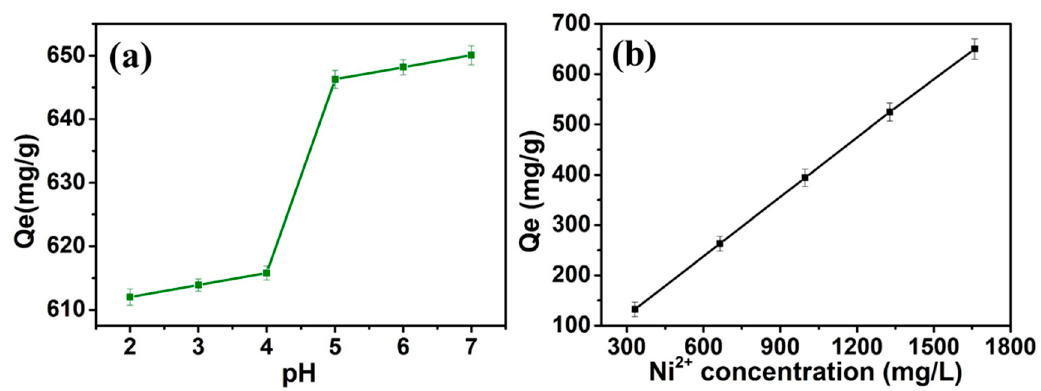
Figure 5. Effect of ( a ) pH ( b ) initial Ni 2+ concentration on the adsorption capacity of Figure 5. E ff ect of ( a ) pH ( b ) initial Ni 2 + concentration on the adsorption capacity of gauze@PEI 0.4 / gauze@PEI 0.4 /PEGDE 1 /TETA 0.6 . PEGDE 1 / TETA 0.6